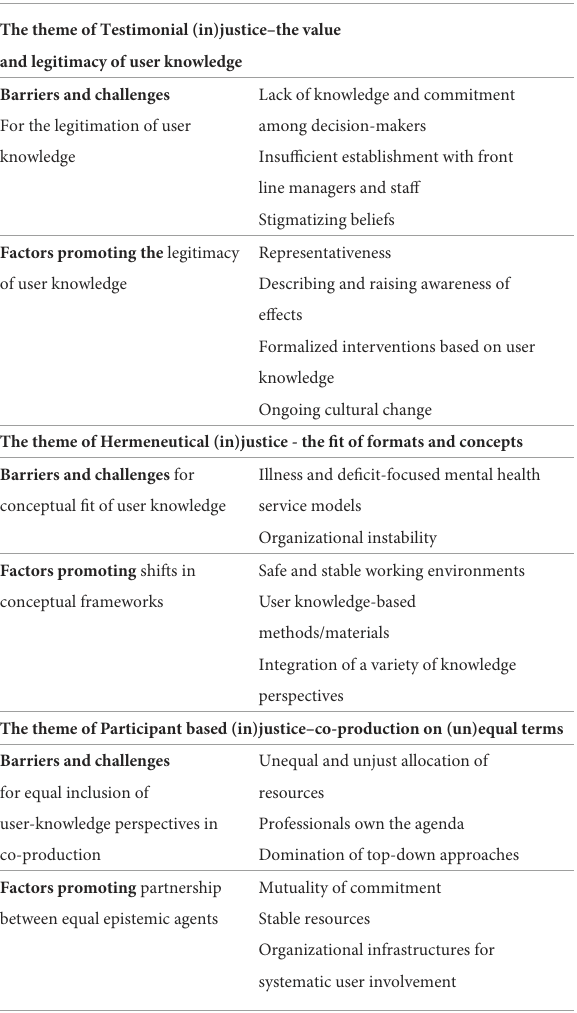
TABLE 3 Themes, categories, sub-categories and examples of